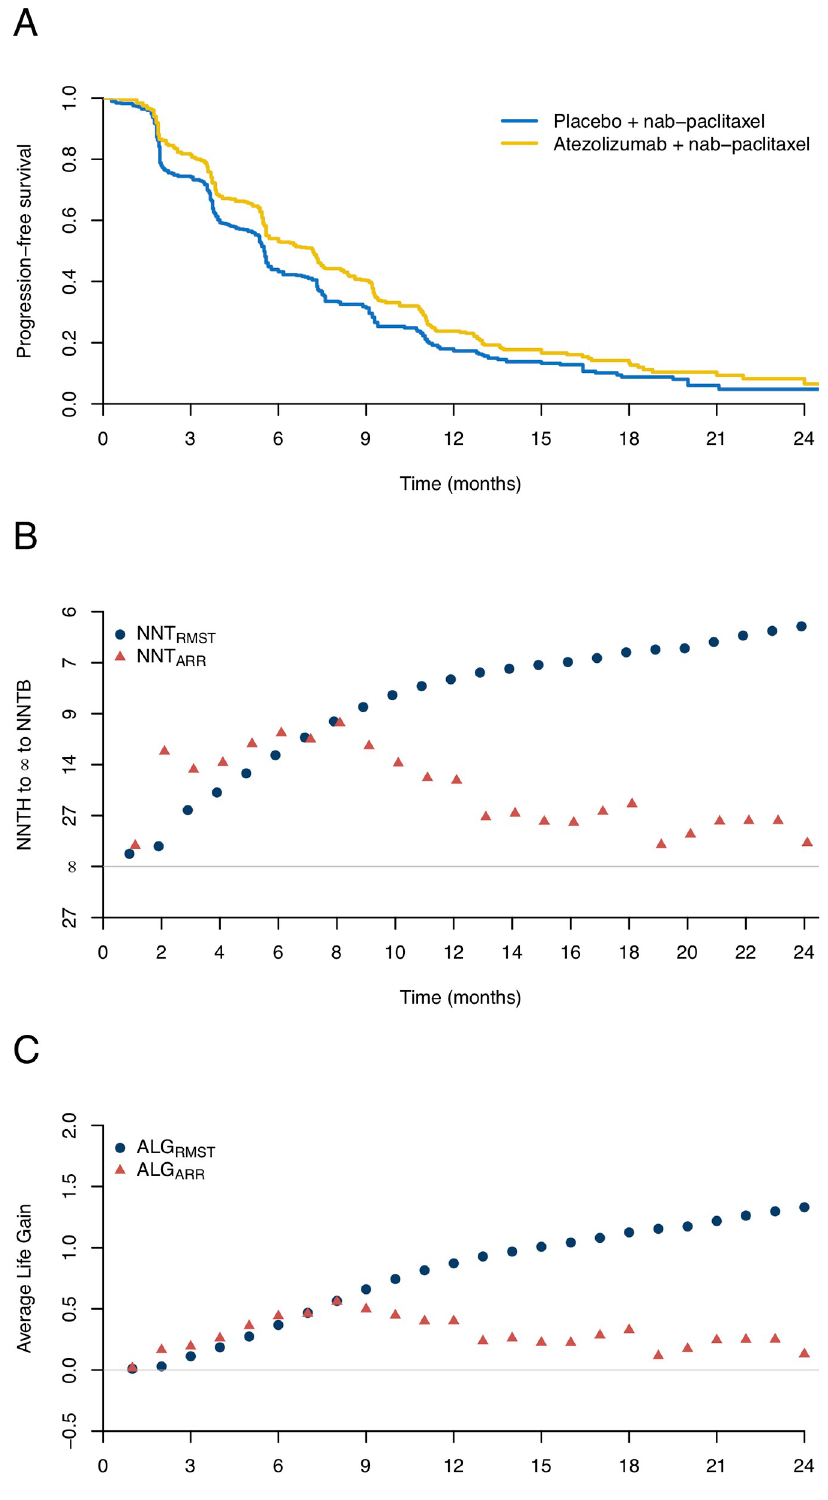
Fig 2. Estimated survival curves, numbers needed to treat (NNTs), and the average life gain (ALG) based on the reconstructed data from the atezolizumab and nab-paclitaxel trial. (A) Kaplan-Meier curves for the atezolizumab